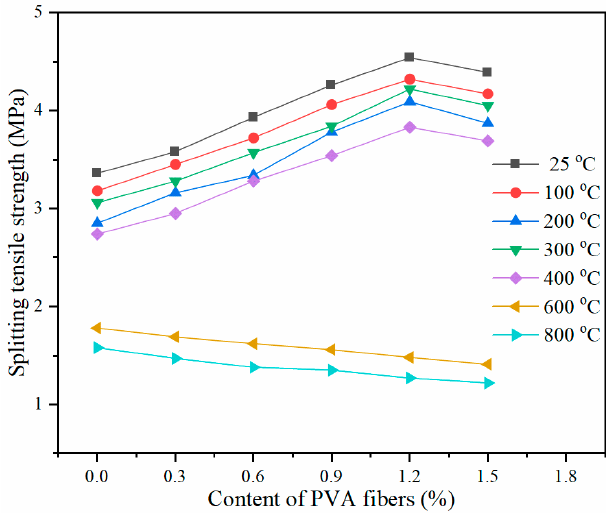
Figure 8. Splitting tensile strength of PVA-FRCC specimens after exposure to different tempera- tures.